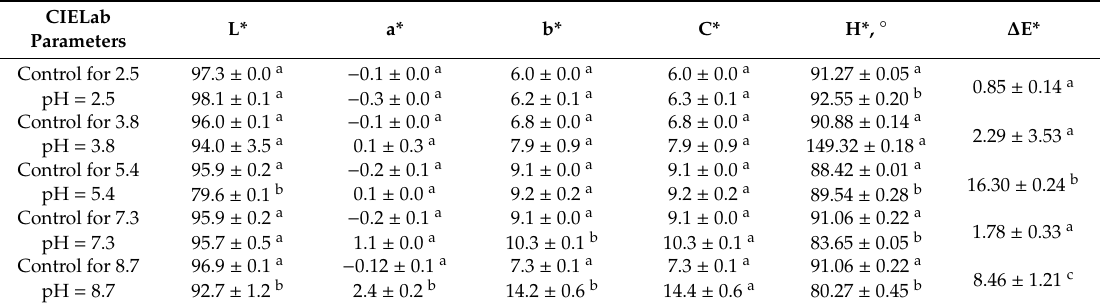
Table 3. CIELab color parameters’ dependence on pH (results are expressed as means ± standard deviation).